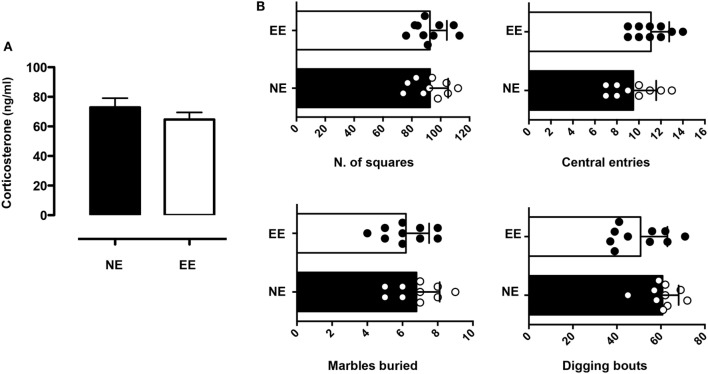
Anxiety-like behavior and plasma corticosterone levels in C57/Bl6 mice after 2 weeks of EE. (A) Levels of plasma corticosterone in mice at the end of 2 weeks housing in NE or EE conditions. Data shown are means ± SEM from n = 5 mice and representative of n = 3 separate experiments with similar results. (B) Mice were tested for the anxiety-like behavior at the end of their 2 weeks of NE or EE housing using the open field (top bar charts) and the light/dark shuttle box (bottom bar charts). The top-graphs show the number of squares traveled (left) or the number of central entries (right) in the open field after 5 min of testing. The bottom graphs show the number of light/dark transitions (left) and the time in the light (right) in the light and dark shuttle box at the end of 10-min test. Data shown means ± SEM from n = 10 mice and are representative of n = 3 separate experiments with similar results.